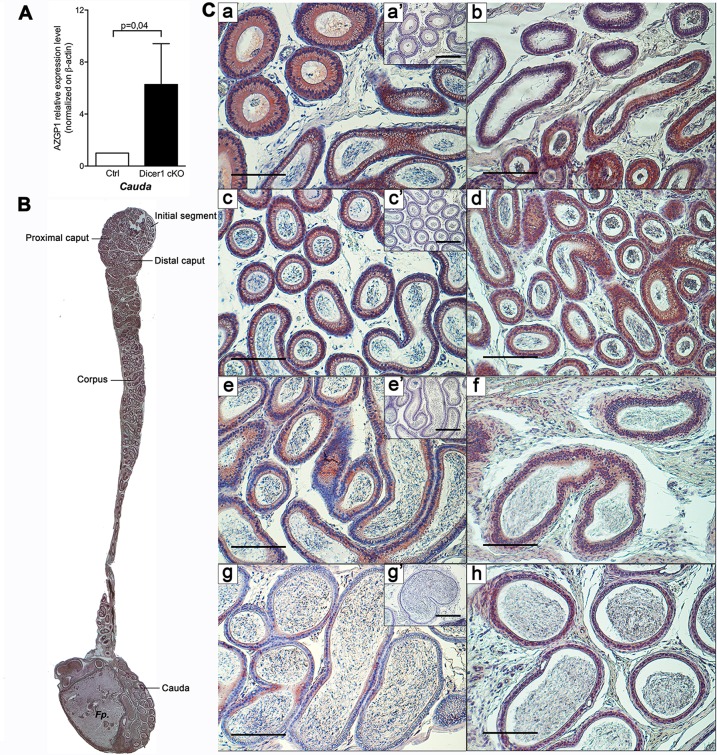
Protein Expression level of Zinc-alpha-2-glycoprotein (AZGP1) in the epididymis of Dicer1 cKO and control mice.(A) Relative quantification of AZGP1 protein in the cauda epididymis of Dicer1 cKO and control mice by western blot. Statistical significance was assessed by Student t-test from n = 3 replicates per group. (B) Longitudinal section of a mouse epididymis from a Dicer1 cKO mouse stained by immunohistochemistry for AZGP1. Image taken at 2.5 X. Fp: Fat pad. (C) Immuno-detection of AZGP1 on the proximal caput (a, b), distal caput (c, d), corpus (e, f) and cauda (g, h) epididymidis of control (a, c, e, g) and Dicer1 cKO (b, d, f, h) mice. Bar = 200 μm. Negative controls in absence of primary antibody are shown in insets (a’, c’, e’, g’). Bar = 250 μm.